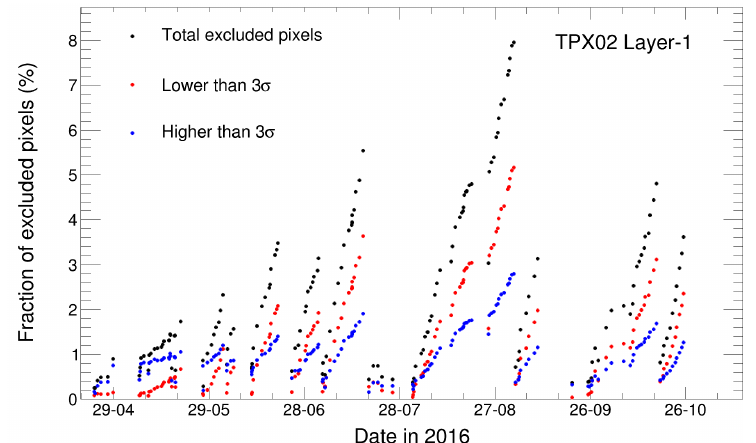
Figure 50. Fraction of excluded pixels for device TPX02 layer 1 as a function of time. The fractions of pixels with a rate below 3 σ are shown in red, whereas the fractions of pixels with a rate above 3 σ are shown in blue. Taken from Ref. [16].